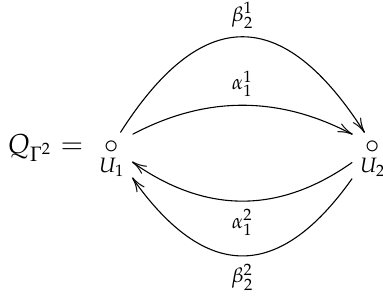
denotes the special cycle associated with the j